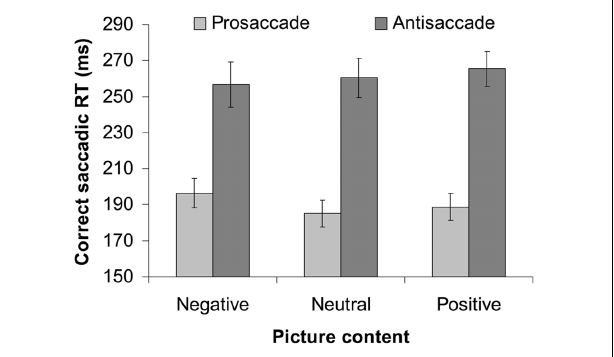
FIGURE 1 | Correct saccadic reaction times as a function of picture content and task